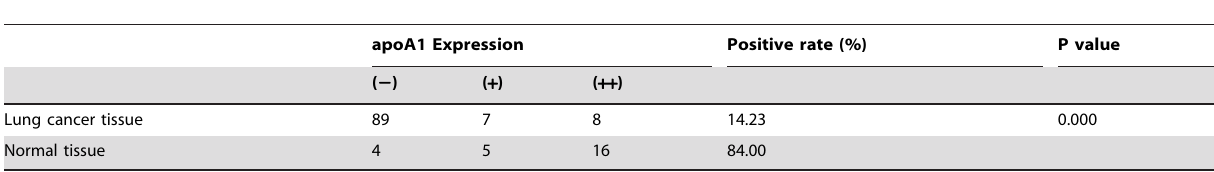
Table 3. Expression of apoA1 in lung cancer and normal tissues.